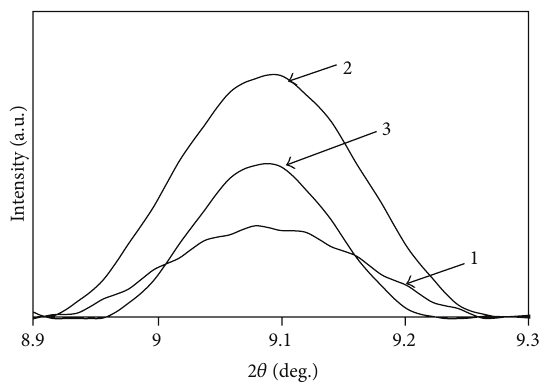
Figure 4: The change of the main diffraction peak of ettringite in samples after 3 h of hydration: 1, OPC; 2, OPC-CAH1; 3, OPC-